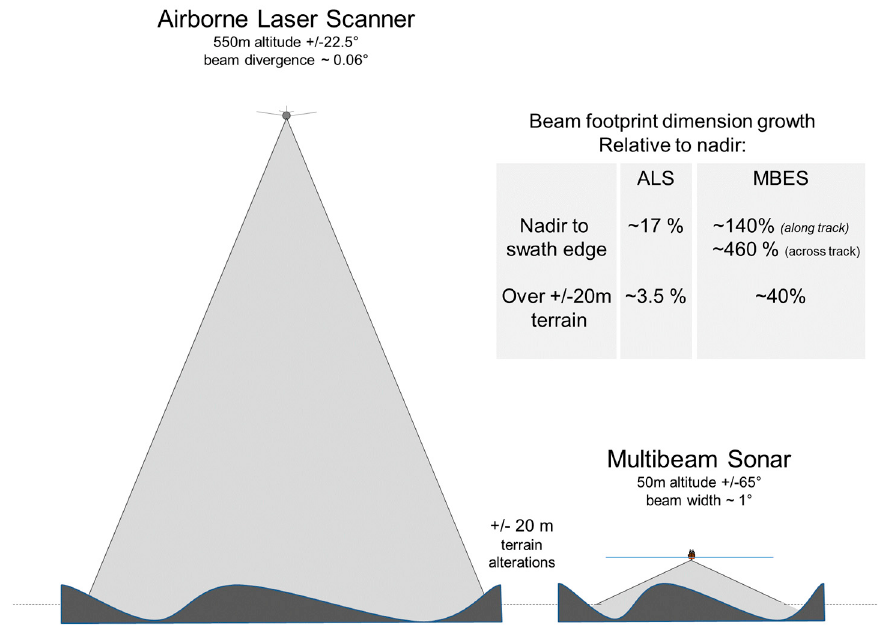
Figure 1. Comparing the imaging geometry of an airborne laser scanner and an equivalent resolution inner shelf multibeam sonar. ALS: Airborne (terrestrial) lidar scanner. MBES: Multibeam echo sounder.